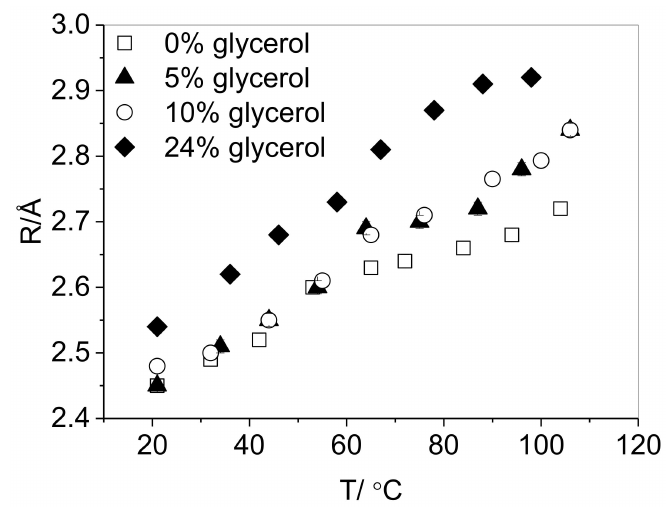
Figure 7. Influence of temperature on the o -Ps lifetime in non-plasticized PVA and PVA containing 0, 5, 10 and 24 wt % glycerol. Error bars are within the size of the data points.